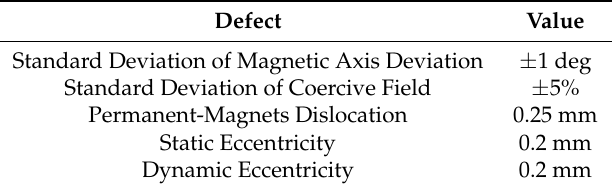
Table 11. Severity of defects used for robustness